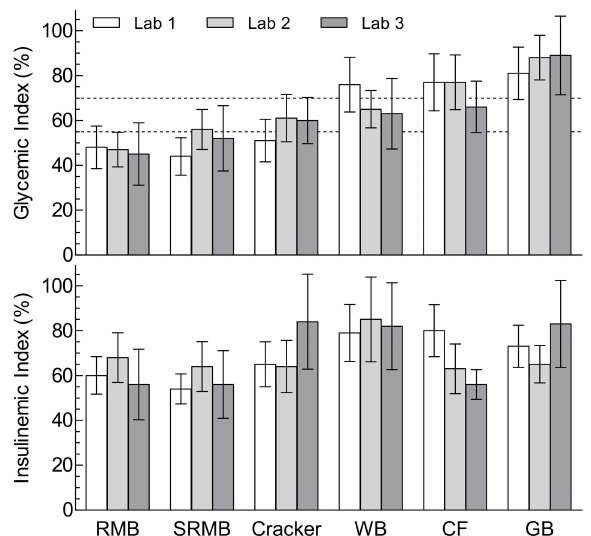
Figure 1. Glycemic index and insulinemic index values for the six foods in the three laboratories. Values are means ± 95% confidence intervals for n = 12–15 participants in each laboratory for glycemic index (top panel) and insulinemic index (bottom panel). Dashed lines on the top panel are drawn at GI = 55 (upper limit of low-GI category) and GI = 70 (lower limit of high-GI category).